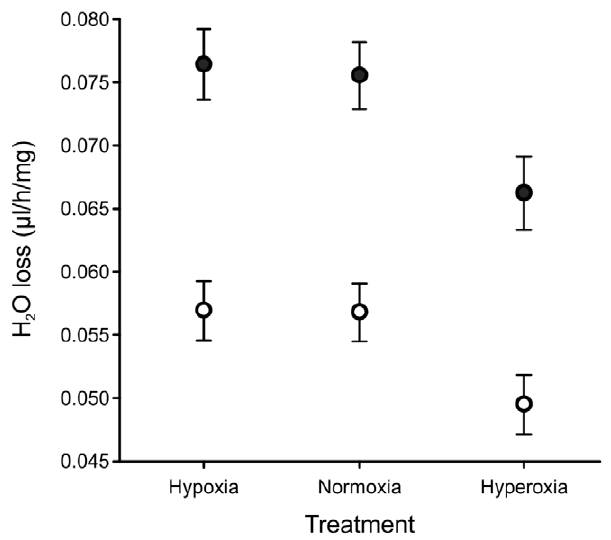
Figure 4. Variation among treatments in water loss rates under normoxic conditions as measured at generation 29(24 hyper- oxia). Male (solid) and female (open) D. melanogaster evolved under normoxic, hypoxic, or hyperoxic conditions and were then raised in a common normoxic environment for two generations prior to conduct- ing the assay. Treatment means 6 SEM of replicate populations are shown for clarity. Body-mass corrected water loss rates were lower in females than in males (p=0.0002), but there was no significant treatment effect (p=0.099) nor sex 6 treatment interaction (p=0.931).